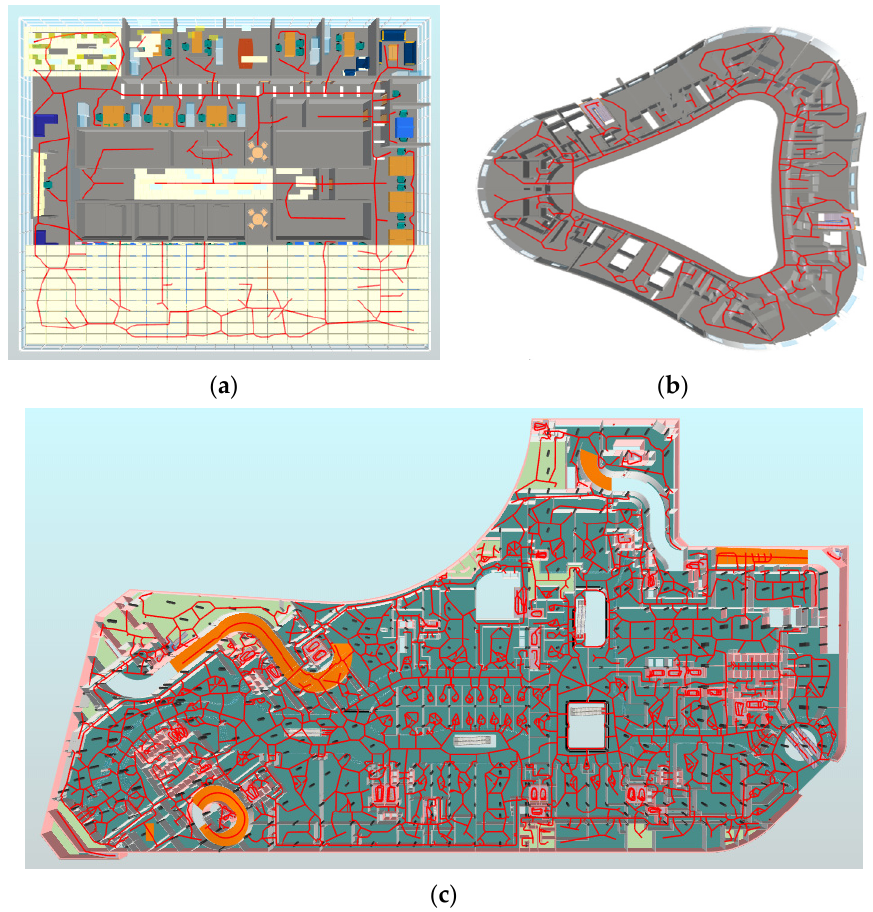
Figure 24. Floor-level topological map: ( a ) office building, ( b ) ring hotel, and ( c ) shopping mall.